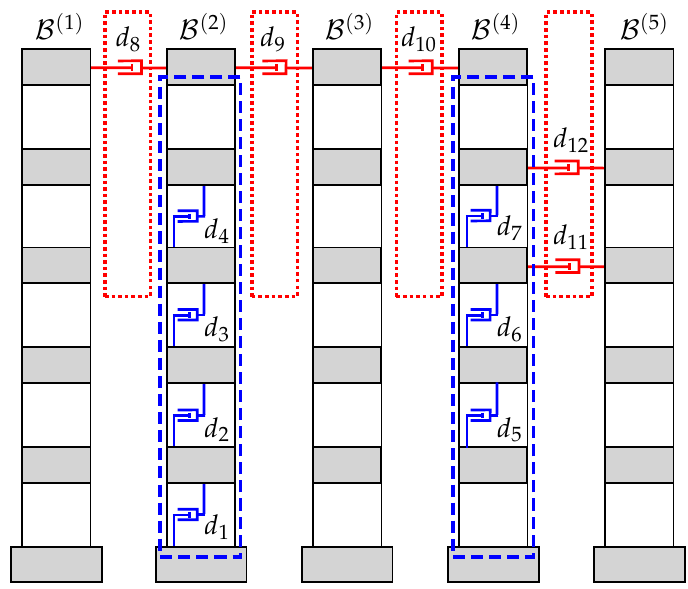
Figure 6. Damping configuration DC2. Full-linked DDS with two actuated buildings, ˆ n = 7 interstory dampers and ˜ n = 5 interbuilding